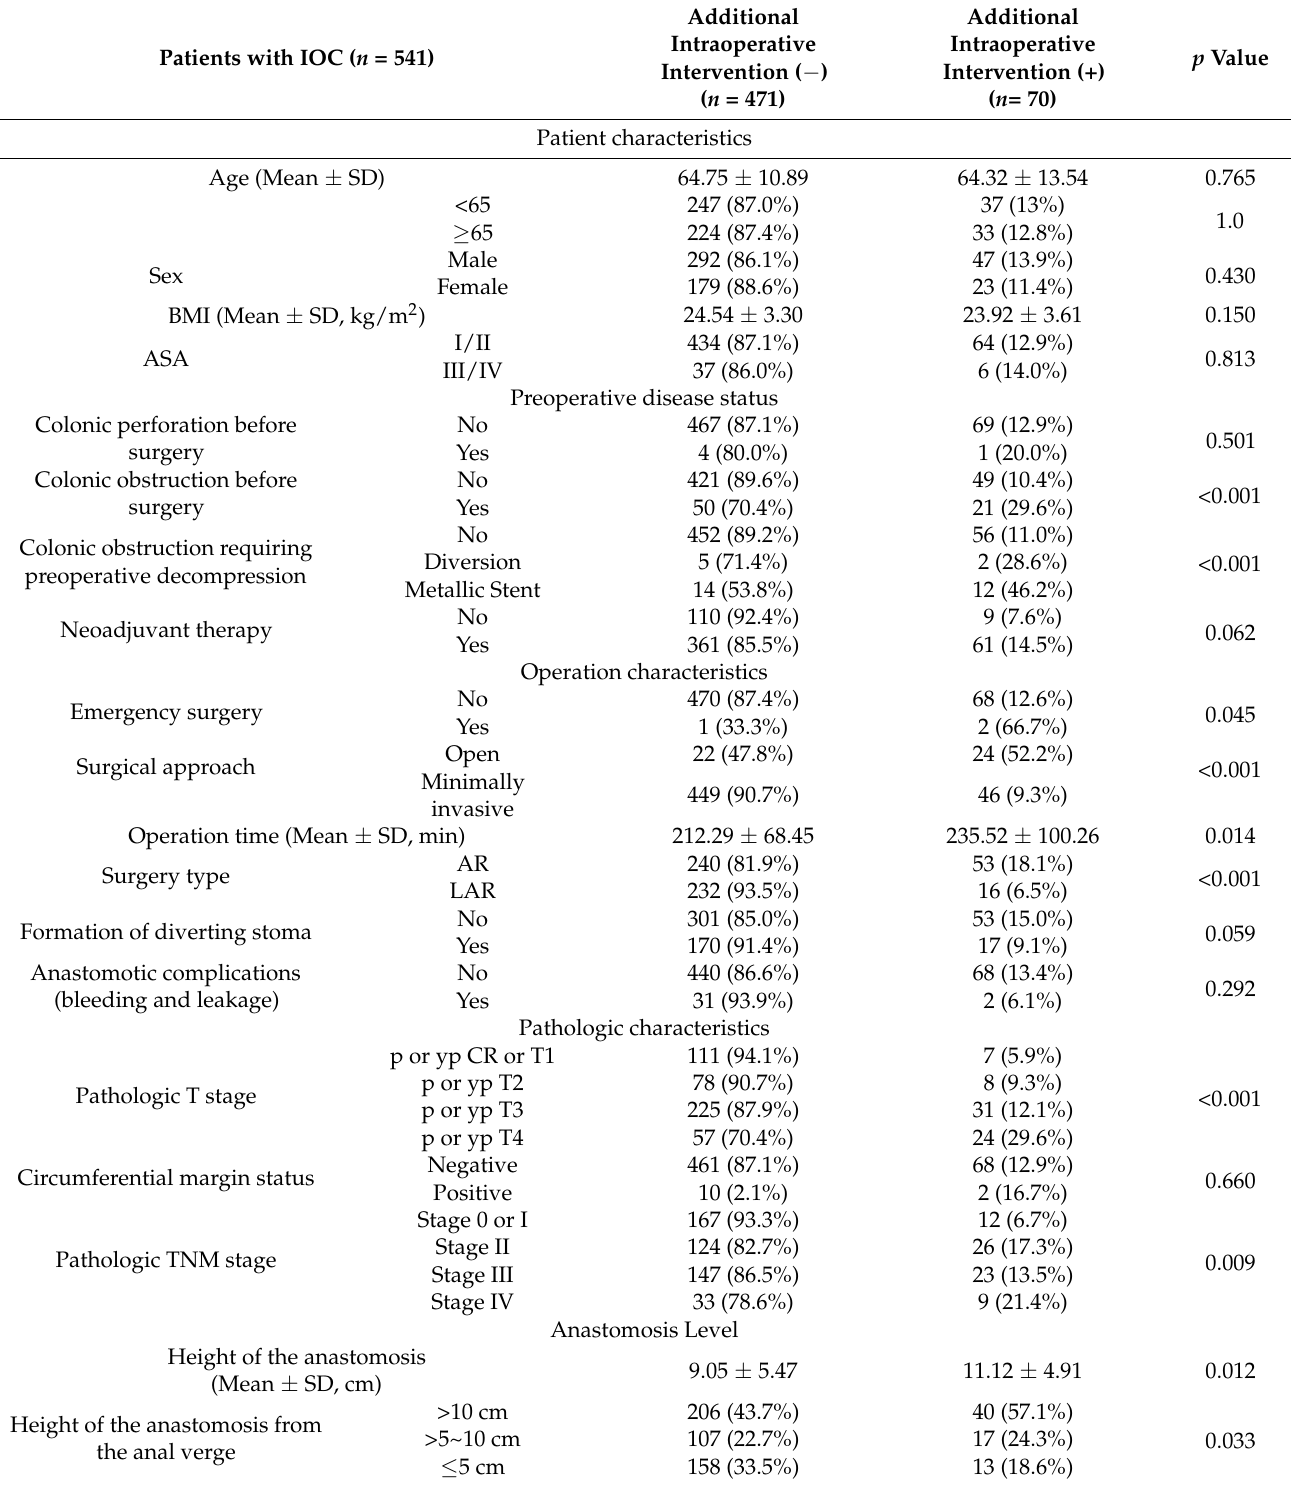
Table 6. Univariate analysis comparing patients with and without additional intraoperative interven- tion after IOC